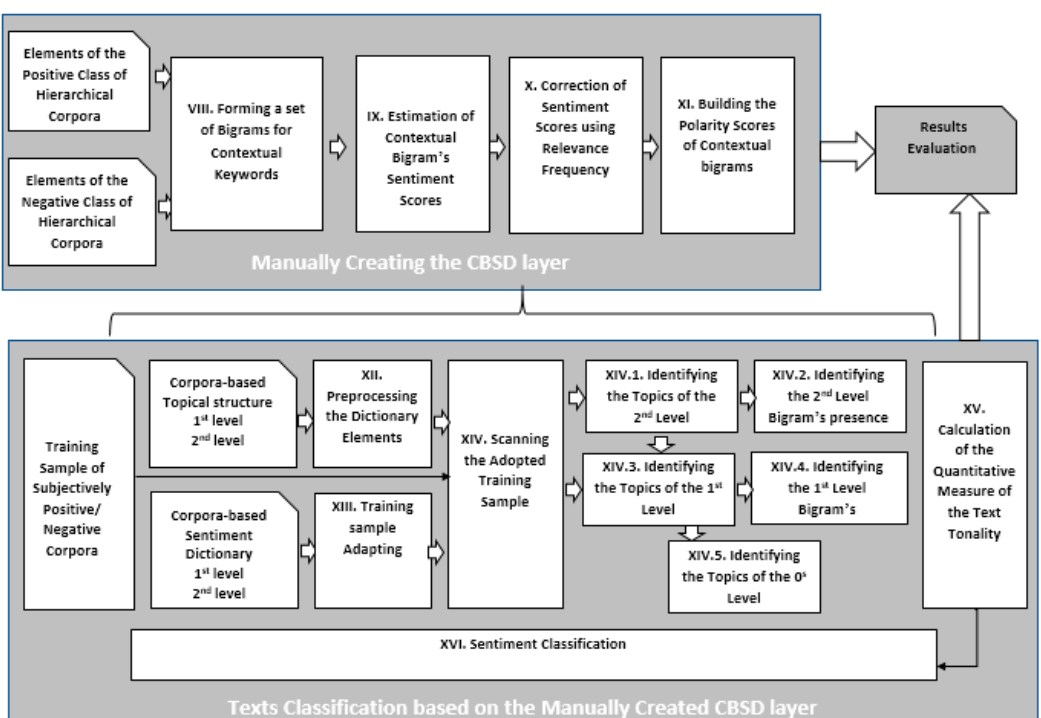
Figure 2. The steps of the sentiment classification based on the CBSD phase. Source: own research results.